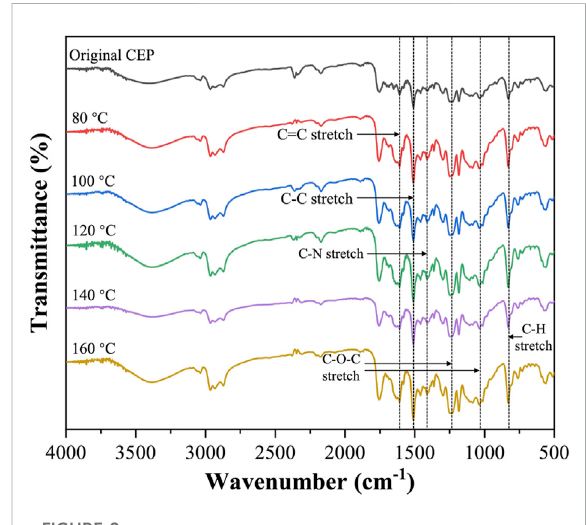
FIGURE 8 FTIRspectraoforiginalCEPandswellingCEPtreatedat80 ° C, 100 ° C, 120 ° C, 140 ° C, and 160 ° C.